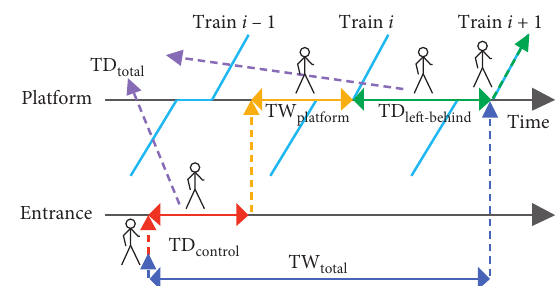
Figure 3: The relationship of delay and waiting time